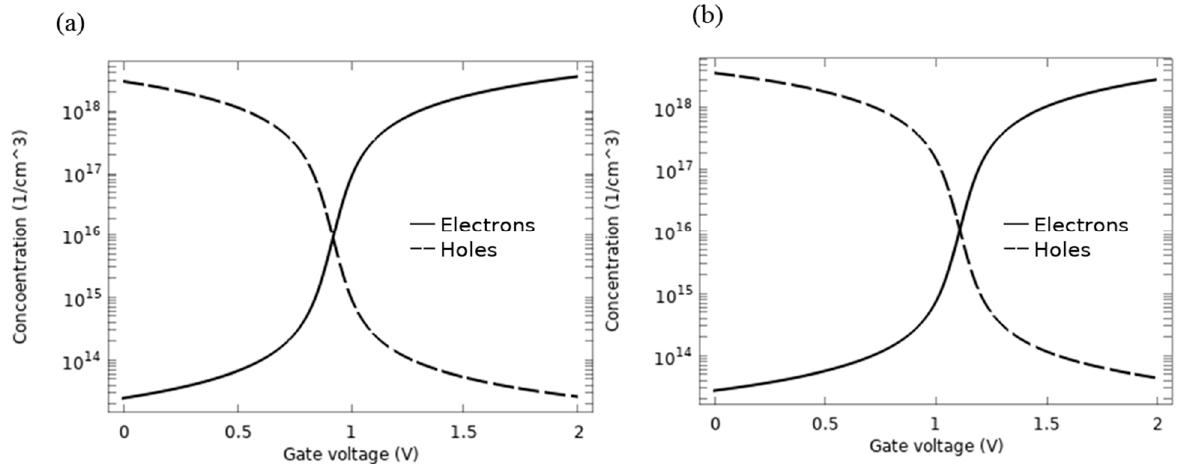
Figure 8. Carrier concentration in the graphene channel versus V g for ( a ) AlP-GFET, ( b ) Pd-GFET. This confirms the occurrence of inversion of the device channel at V n .